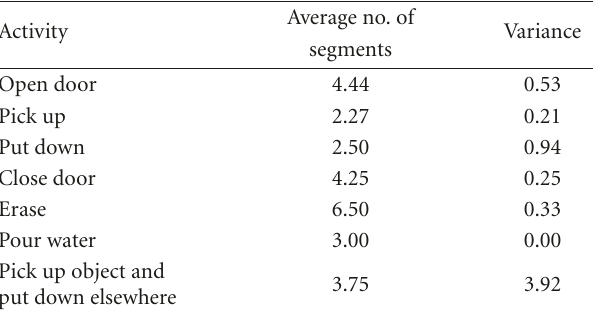
Table 6: Number of segments detected for activities in the UCF indoor human action